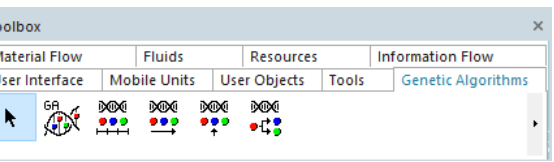
Figure 4. Objects which provide genetic algorithms in software Tecnomatix Plant Simulation.